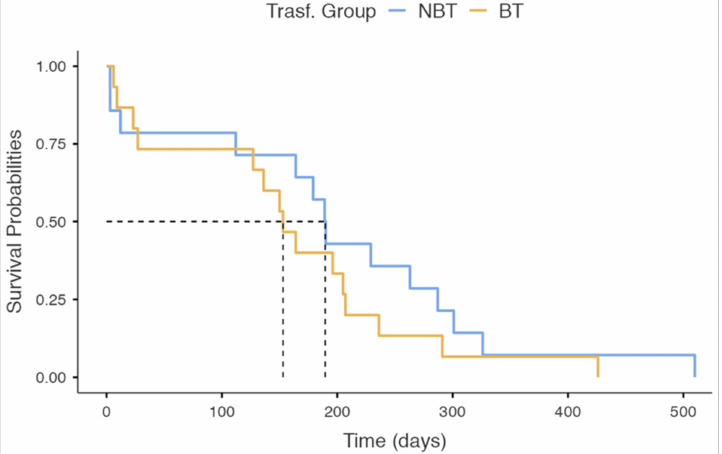
Figure 3. Kaplan–Meier survival plot between NBT and BT groups with a 1.5-year